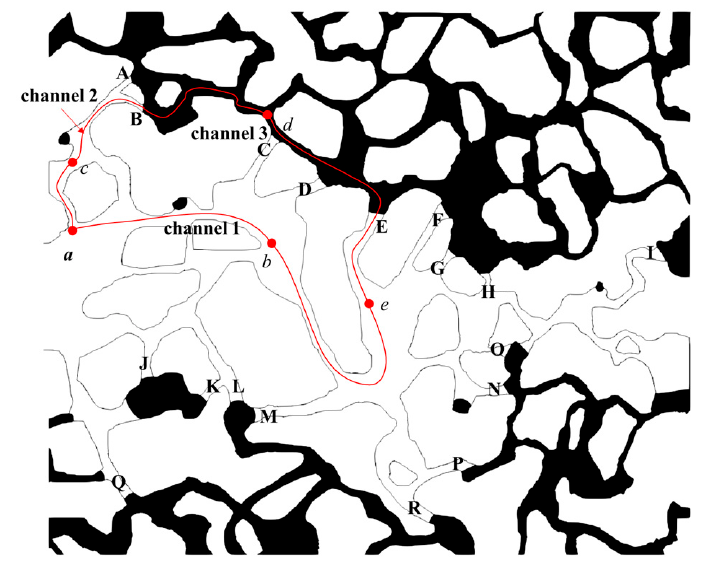
Figure 2. Oil and water two-phase distribution (black represents oil, white represents